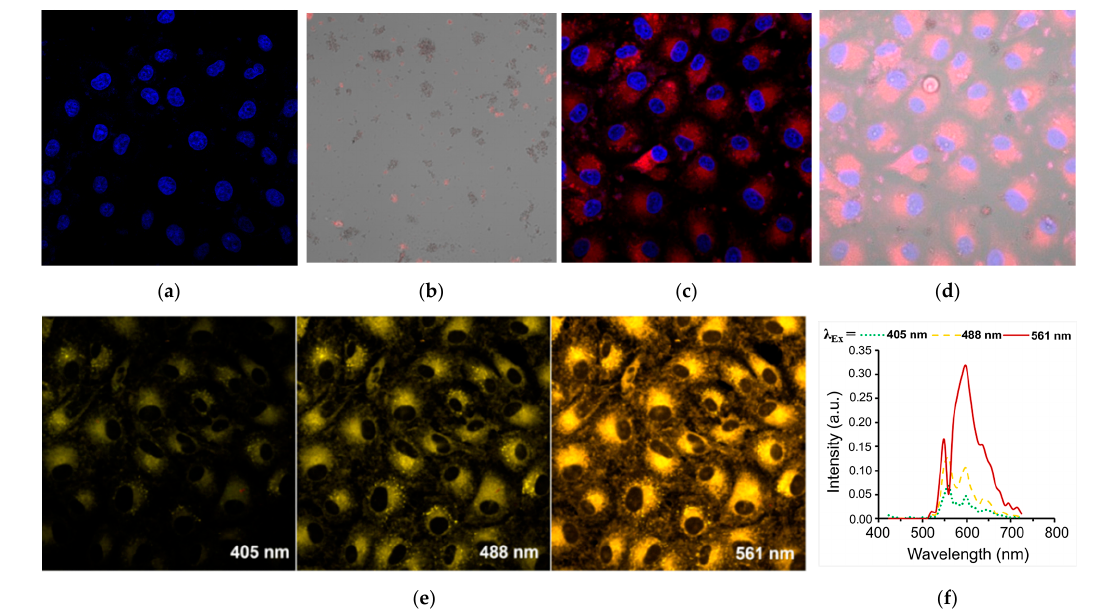
Figure 9. Images of ( a ) cells stained with nuclear dye and captured in channel mode with 405 nm excitation; ( b ) NC 18 taken in channel mode with 561 nm excitation, overlapped on image captured in transmission light mode; ( c ) cells stained with nuclear dye (blue) and Dox (red) desorbed from NC 18 (captured in channel mode with λ Ex = 405 and 561 nm), and ( d ) overlapped on image cap- tured in transmission light mode. ( e ) Cell images taken in the lambda mode when excited by lasers of different wavelengths (405, 488 and 561 nm). ( f ) Fluorescence spectra extracted from the lamb- da-images with different excitation.